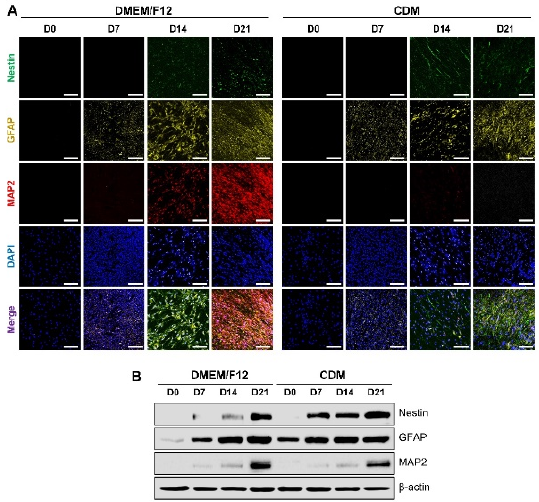
Figure 2. Confirmation of neuronal differentiation ability of ADMSCs. ( A ) Representative immunofluorescence staining images of differentiated ADMSCs labeled with neuronal markers: Nestin (green), GFAP (yellow), and MAP2 (red) after 0, 7, 14, and 21 days under neural differentiation conditions. DAPI (blue) represents the nuclei of ADMSCs. Scale bars indicate 200 µ m. ( B ) Western blot analysis results with neuronal markers: Nestin, GFAP, and MAP2. β -actin served as a loading control.